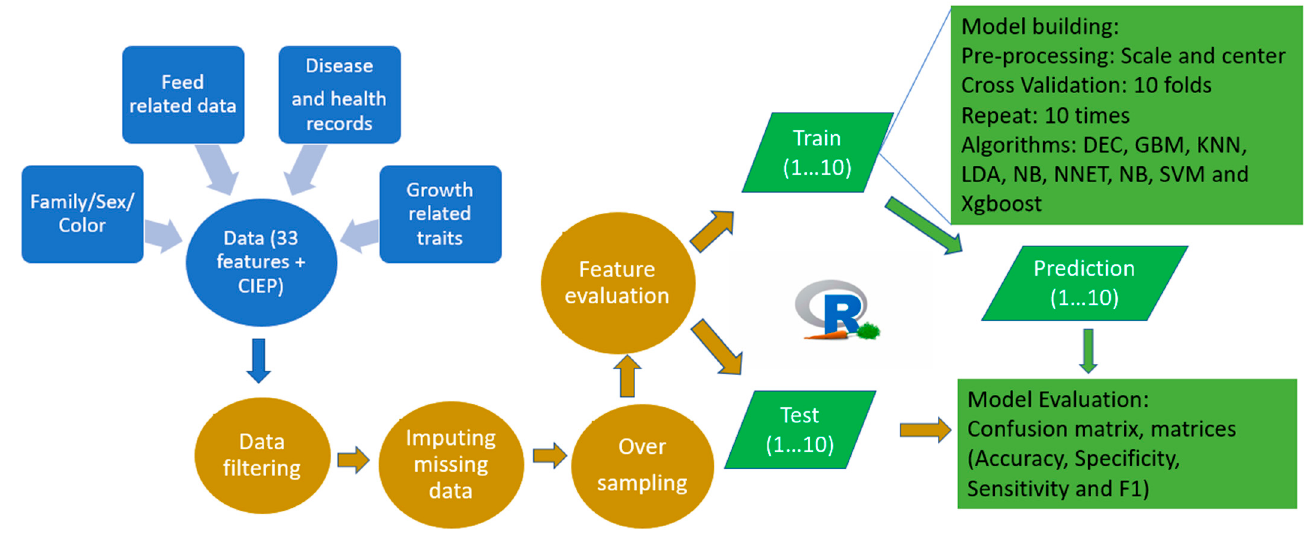
Figure 1. A simplified workflow representation of the current study .